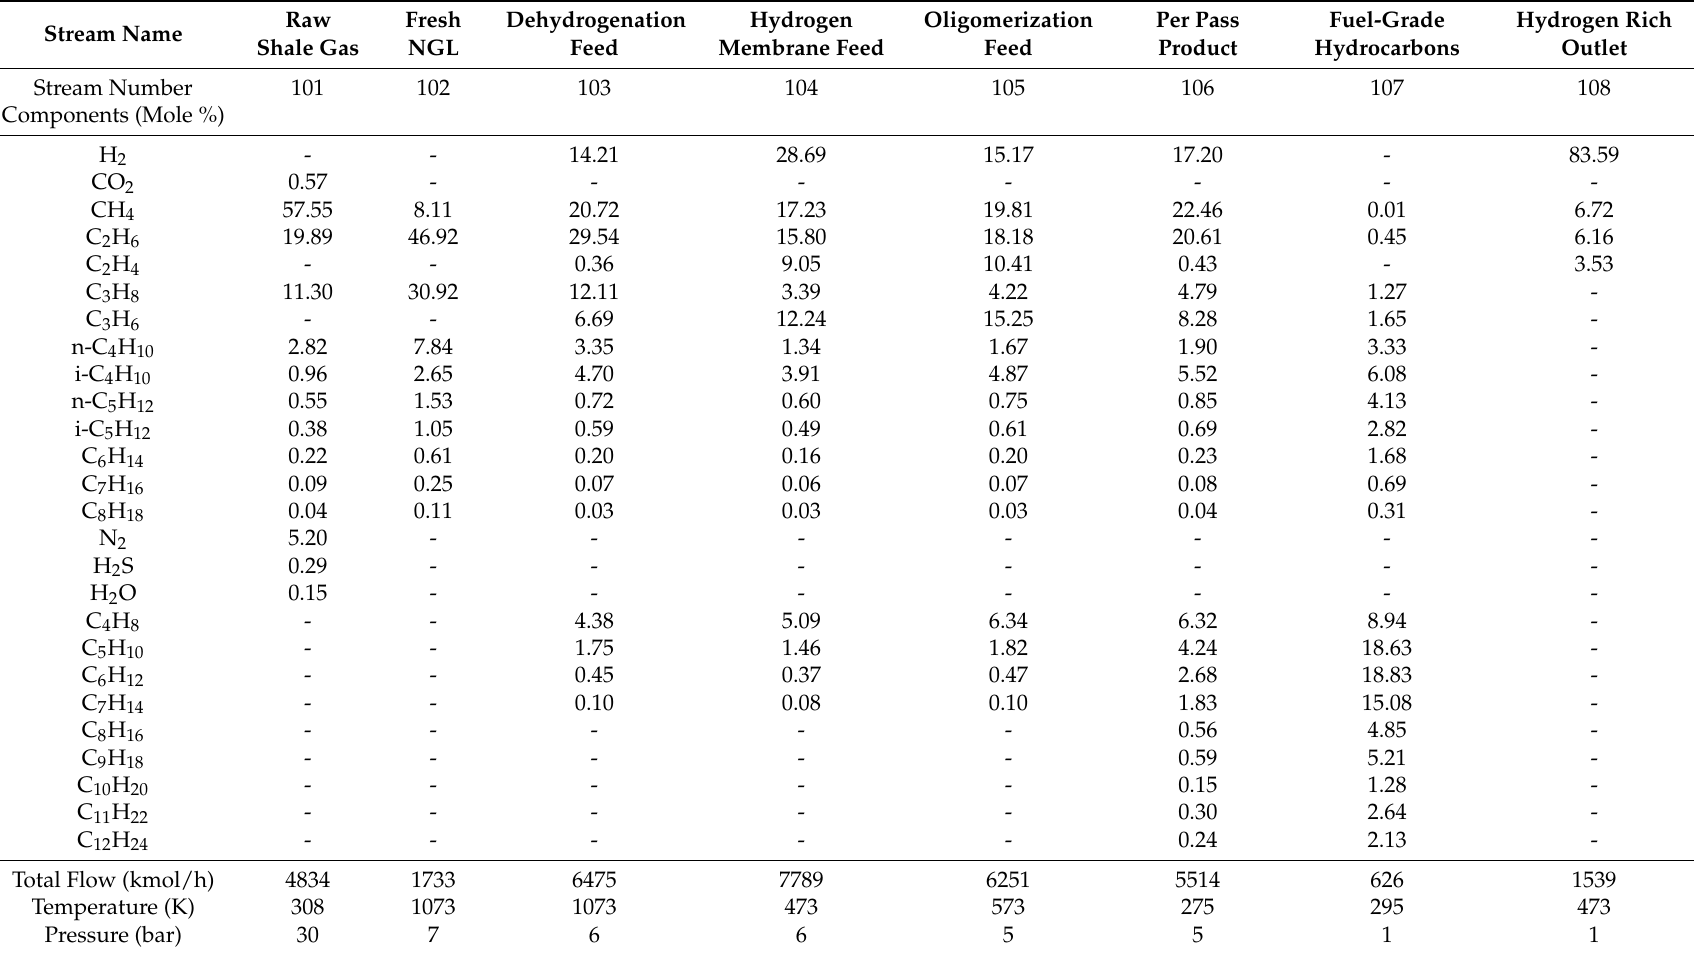
Table 2. Key stream data for Process I. NGL: natural gas